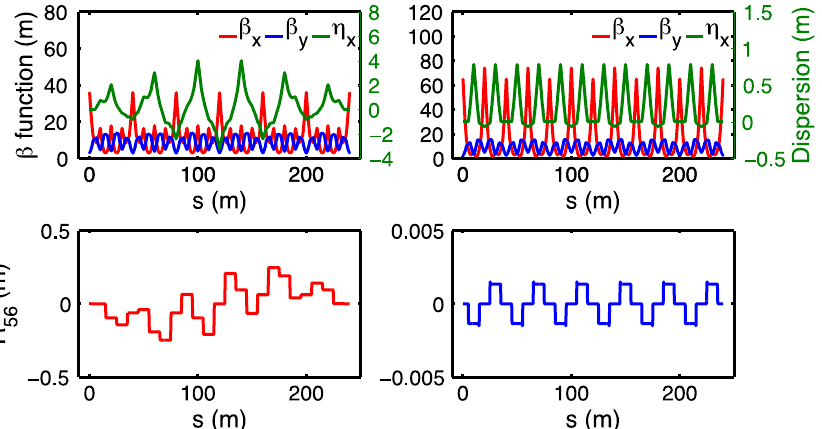
FIG. 1. Twiss and R 56 transport functions for 1.3 GeV high-energy transport arc: (a) and (c) with large momentum compaction